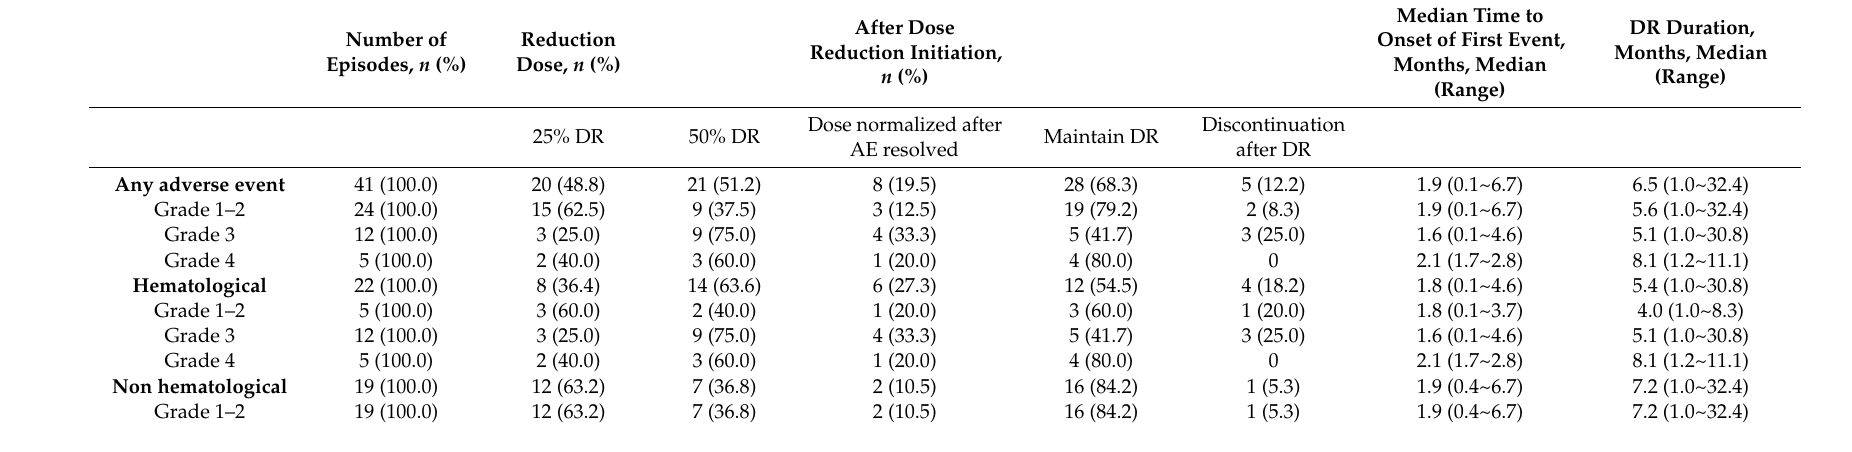
Table 4. Dose reduction (DR)